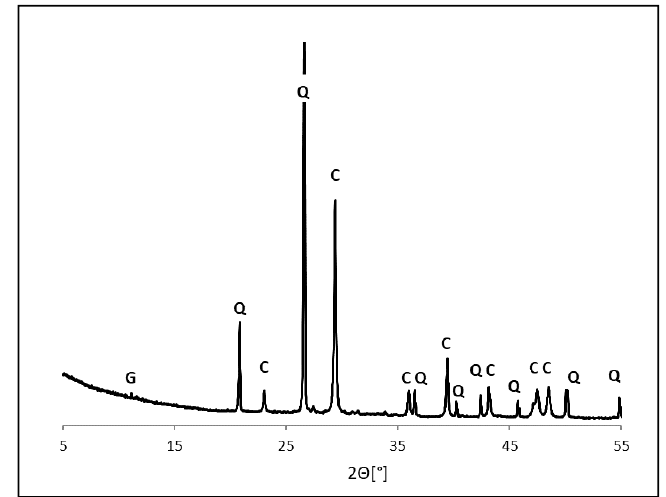
Figure 8. A diffractogram of a sample of concrete taken from loggia wall near point (1–12). Signs: C—Calcite, Q—Quartz, and G—Gypsum.